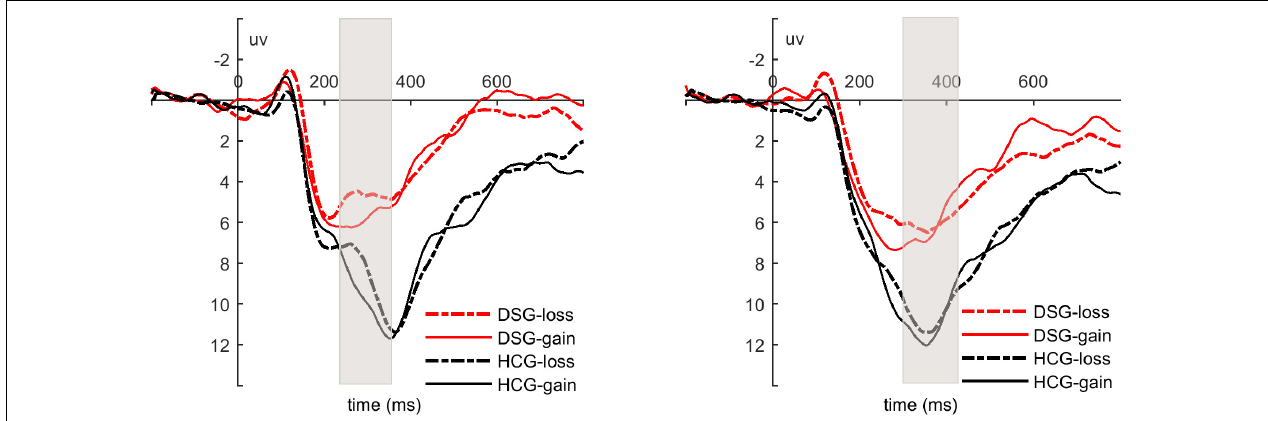
FIGURE 2 | Left panel: Grand average waveforms for RewP averaged across the electrode sites of FCz, FC1, FC2, Fz, Cz; Right panel: grand average waveforms for fb-P3 averaged across the electrode sites of CP1,CP2, Pz, Cz. DSG = depressed status group. HCG = healthy control group.